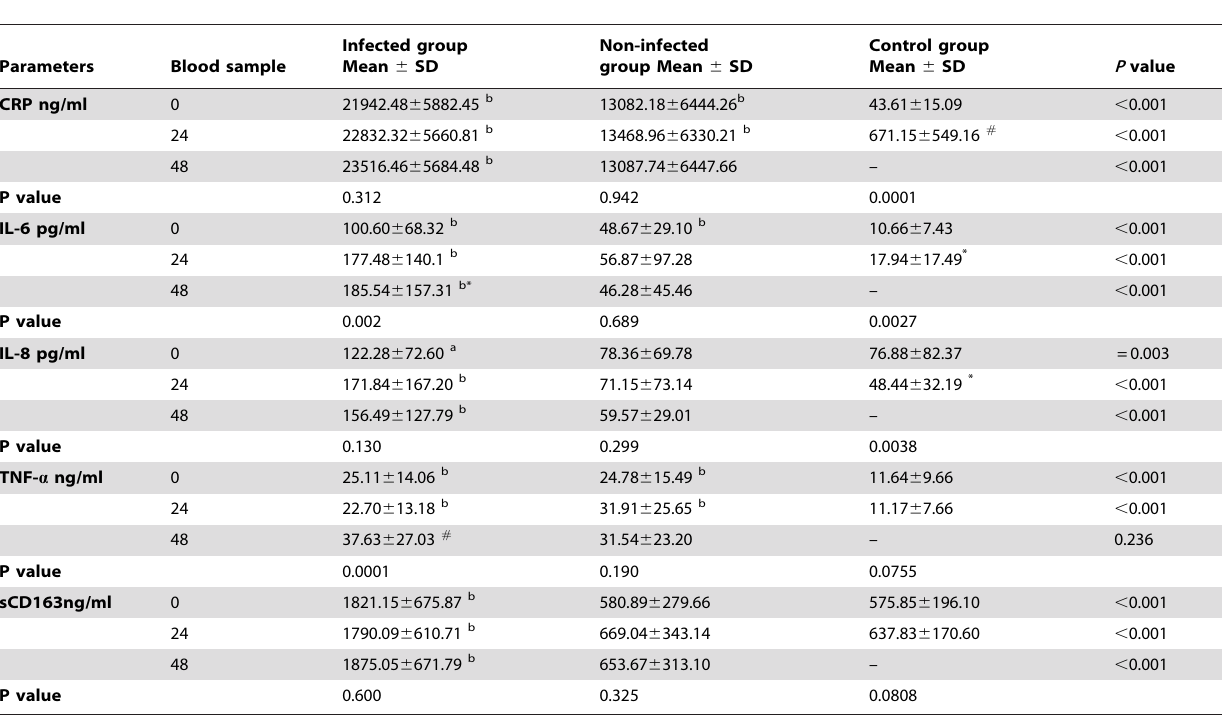
Table 3. The mean and standard deviation of the various study parameters in the infected, non-infected and control group at different time